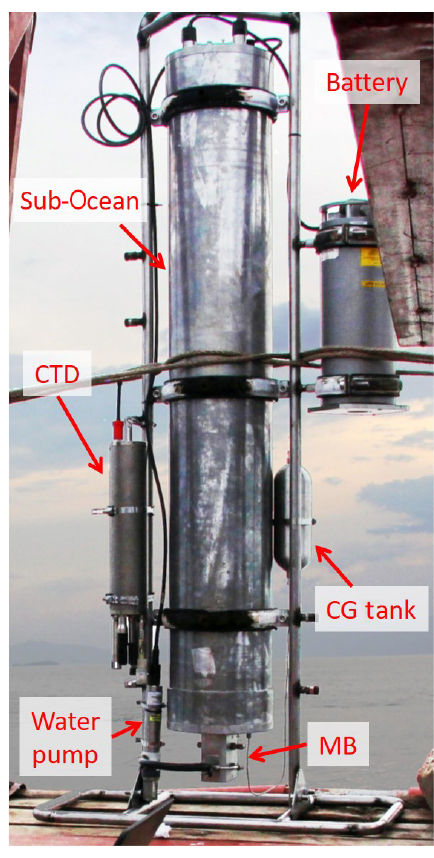
Figure 2. A picture of the Sub-Ocean instrument and the full assem- bly. The sensor is mounted on a metal frame. The main tube at the center is 150cm long and 28cm in diameter. The membrane block (MB) at its bottom is connected to the water pump to ensure a con- stant flow of water against the membrane. The carrier gas (CG) tank is attached to the metal frame and connected with a 1 / 8in. stainless- steel tube at the instrument. An STR battery pack and a CTD sensor were also attached to the metal structure. The total weight of the assembly is 120kg with about − 50kg of